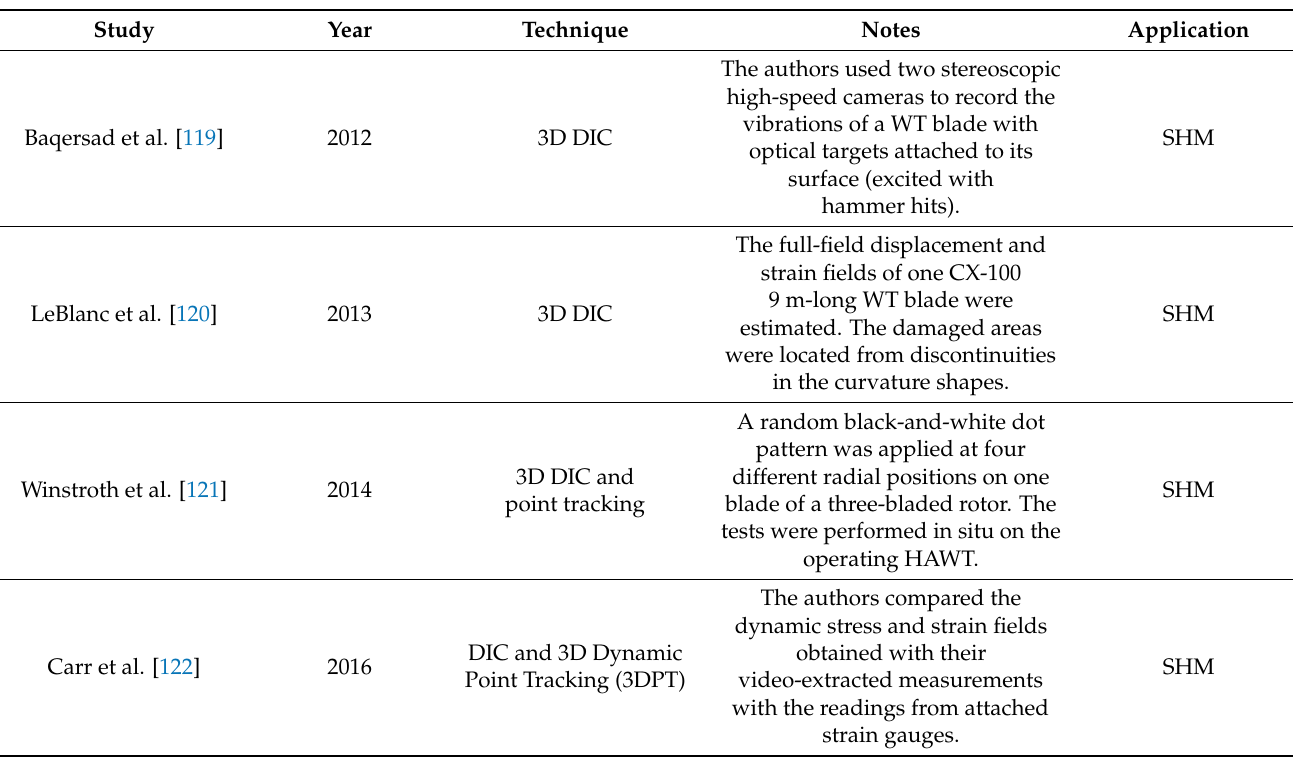
Table 6. Some notable and recent examples of DIC and other optical techniques applied for the NDE of wind